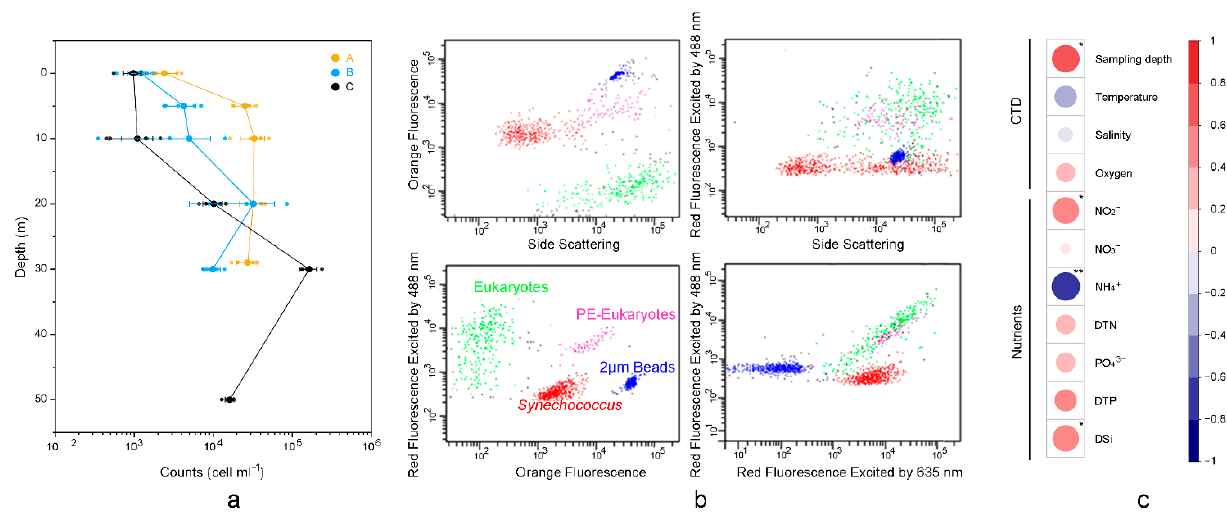
Figure 2. Cell abundance of Synechococcus measured using flow cytometry at each station. ( a ) Line chart showing the relationship between cell abundance of Synechococcus and depth. ( b ) Flow cytometric signatures of Synechococcus , eukaryotes, and PE-eukaryotes. ( c ) Correlationships between Synechococcus count and physicochemical variables; The color scale on the right represents their Spearman correlation coefficient. “**” denotes p < 0.01, “*” denotes p < 0.05.